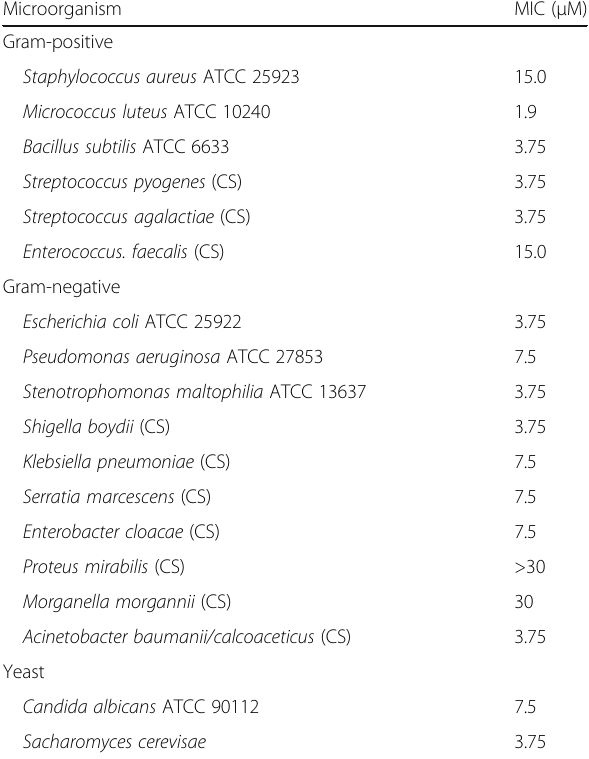
Table 7 Minimum inhibitory concentration (MIC) of